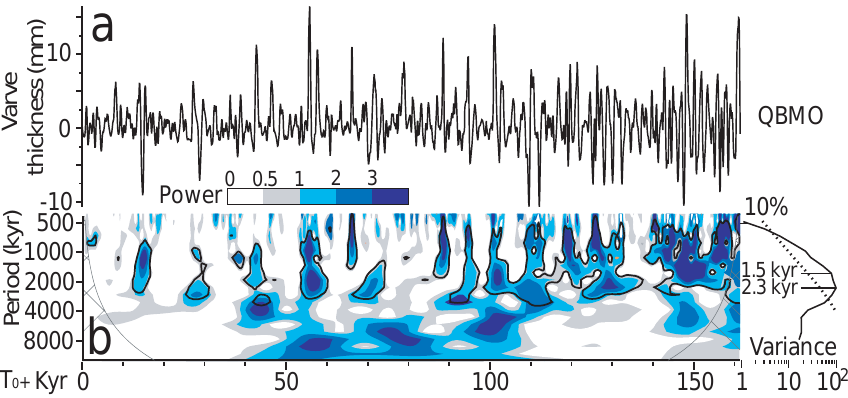
Fig. 4. Quasi-bi-millennial oscillation (QBMO) in Castile series. (a) Filtered series after removing ∼ 100kyr oscillations with polynomial. Note systematic increase in amplitude of QBMO over time, and intermittent expression of larger oscillations. (b) Morlet wavelets of series in (a) as defined by 10% noise limit (black outline; Torrence and Campo, 1998). Temporal separation of outlined centroids corresponds to precession period in first half of series. Separation includes semi-precession period in second half. Centroids spaced at precession and semi-precession periods are amplified in 2.3kyr to 1.5kyr (QBMO) band in global spectrum. (a) Series of Castile decadal values trimmed to 2std. Dev. > 1kyr running mean; ∼ 100kyr oscillations removed with 3rd-order polynomial. Series filtered with 590yr triangular filter and re-sampled at ∼ 100yr. (b) Morlet wavelet of series in (a) , black outline=10% red noise